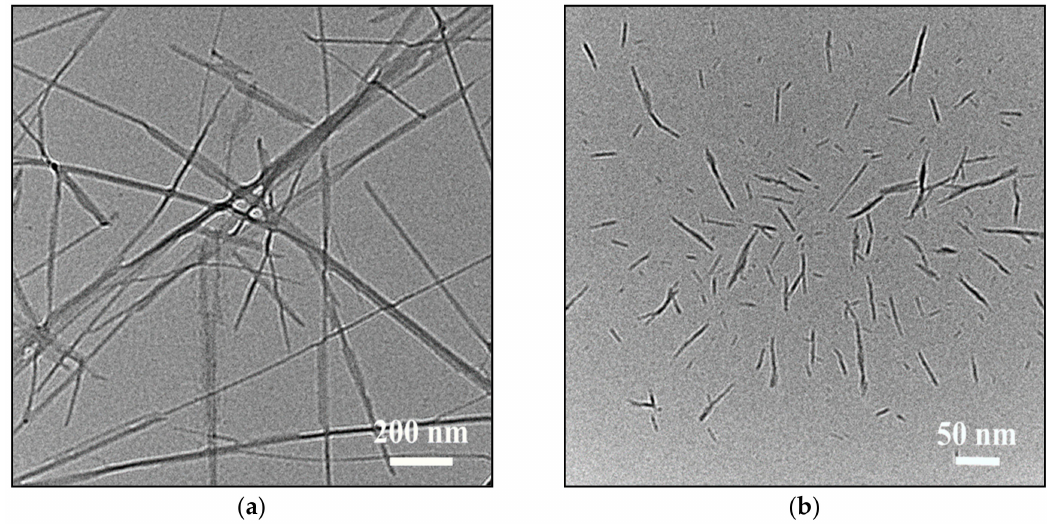
Figure 11. TEM images of ( a ) tunicate cellulose nanocrystals and ( b ) α -cellulose nanocrystal.